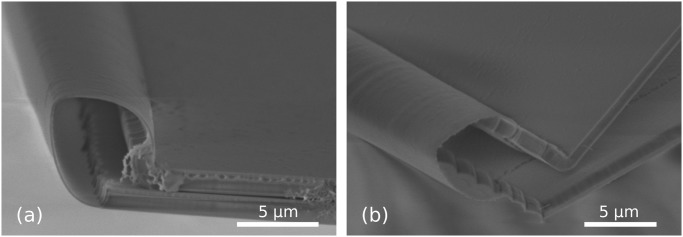
Folding results of 90° stop-programmable hinges.(a): The thick part of the complex hinge is too short (1.8 ± 02) μm) and fails to stop the folding. Consequently, the flap is 180° folded. (b): For this sample, the thick part is slightly longer (3.2 ± 02) μm). This forces folding to stop at an intermediate position, but fails to stop the folding at 90° as was intended.